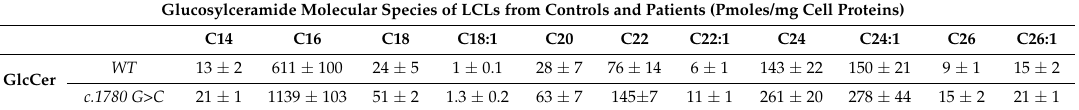
Table 2. SFC-MS/MS analysis of glucosylceramide (GlcCer) molecular species in control (WT, n = 4) and patient (c.1780G>C, n = 3) derived LCLs. Data are the mean of three independent experiments and are expressed as pmoles/mg of cell proteins ±